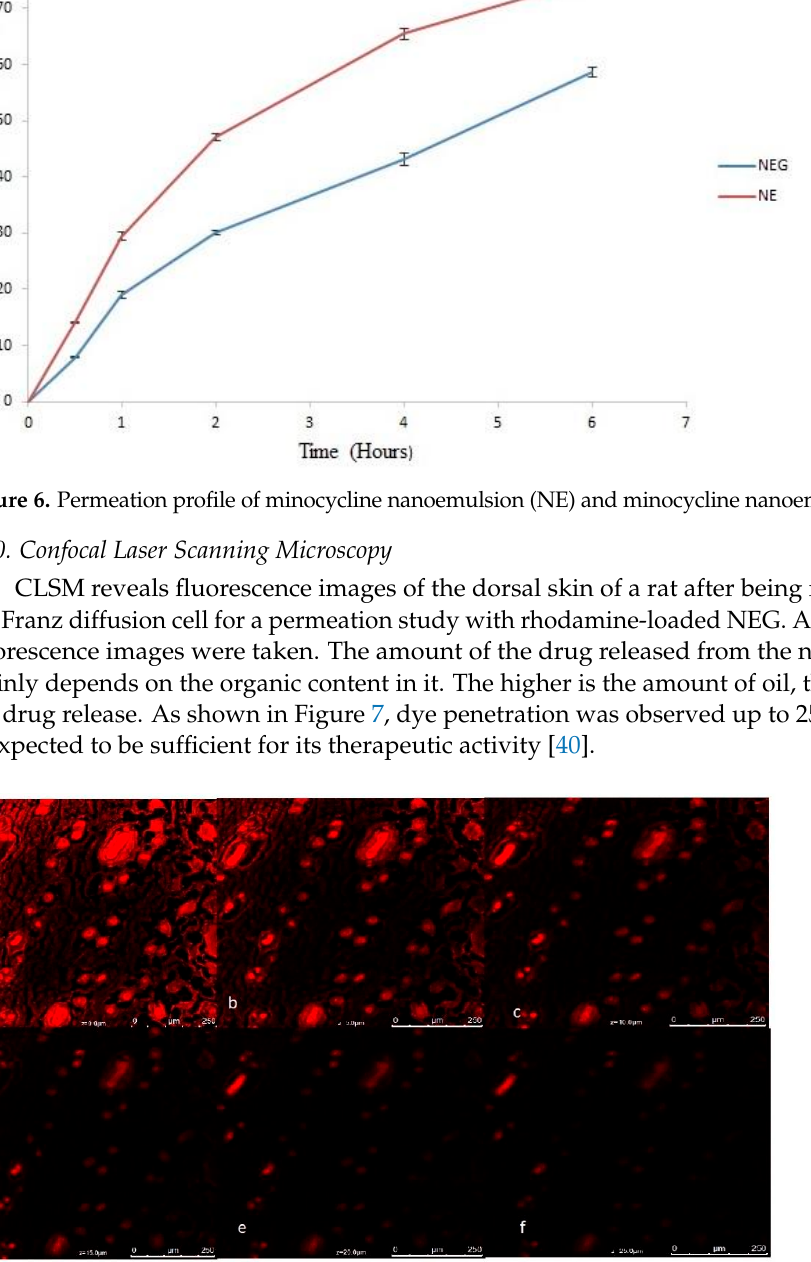
Figure 5. Release profile of minocycline nanoemulsion (NE) and minocycline nanoemulgel (NEG).